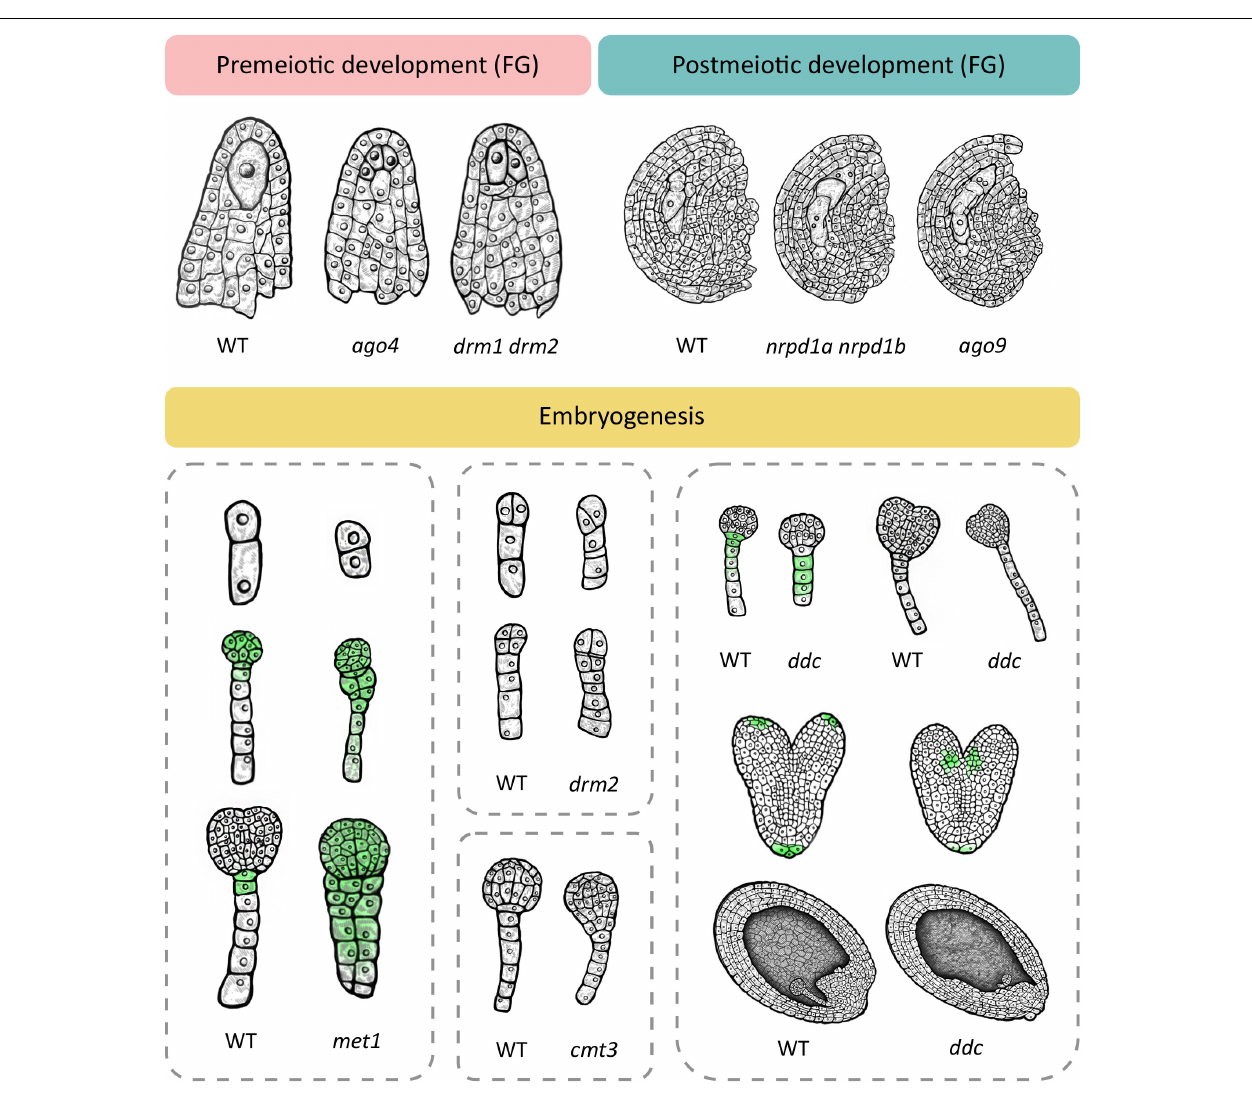
FIGURE 2 | Loss of function of different methylation mechanisms leads to several dominant phenotypes at the premeiotic and postmeiotic stage and during embryogenesis. Premeiotic development. In wild type, one cell of the ovule is specified as the megaspore mother cell (MMC) which divides meiotically to give rise to the female gametophyte (FG). Several mutants with non-functional RdDM develop multiple MMC-like cells in premeiotic ovules, exemplified here in ago4 and drm1 drm2 . Postmeiotic development. The wild type megaspore divides mitotically to produce a female gametophyte. RdDM mutants such as ago9 and the double nrpd1 nrpd2 mutant exhibit two female gametophytes in postmeiotic ovules. Embryogenesis. Wild type embryogenesis begins with zygote elongation, asymmetrical division and subsequent formation of embryo and suspensor. In the met1 mutant with non-functional MET1, the zygote remains short and divides symmetrically (top) and longitudinal divisions in the suspensor lead to unclear demarcation of the embryo-suspensor border (middle and bottom) . Additionally, auxin transport is disturbed which leads to even distribution of auxin throughout the embryo (green). The cmt3 mutant with non-functional CMT3 also shows unclear demarcation of the embryo-suspensor border in early globular stage. Loss of function of RdDM leads to similar aberrations. The drm2 mutant shows disturbed patterns of cell divisions in the early embryo in both the suspensor (top and bottom) and the embryo proper (bottom) . The triple drm1 drm2 cmt3 mutant ( ddc ) exhibits a reduced number of suspensor cells at the globular stage with a hypophysis devoid of auxin signal (top left) and a longer suspensor at early heart stage (top right) . At the heart stage, auxin maximums appear basally from cotyledons (middle) . Wild type embryos are positioned in parallel with the top–bottom axis of the ovule. In a portion of ddc mutant plants, embryos are positioned perpendicular to the axis, and the endosperm is histologically disorganized (bottom) . This schematic image was created based on phenotypes described in relevant scientific articles. For details and references, see Supplementary Table 1